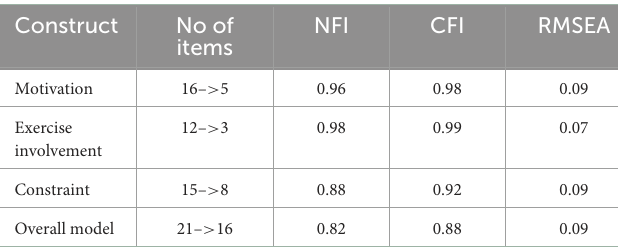
TABLE 6 CFA for each construct and the research model.